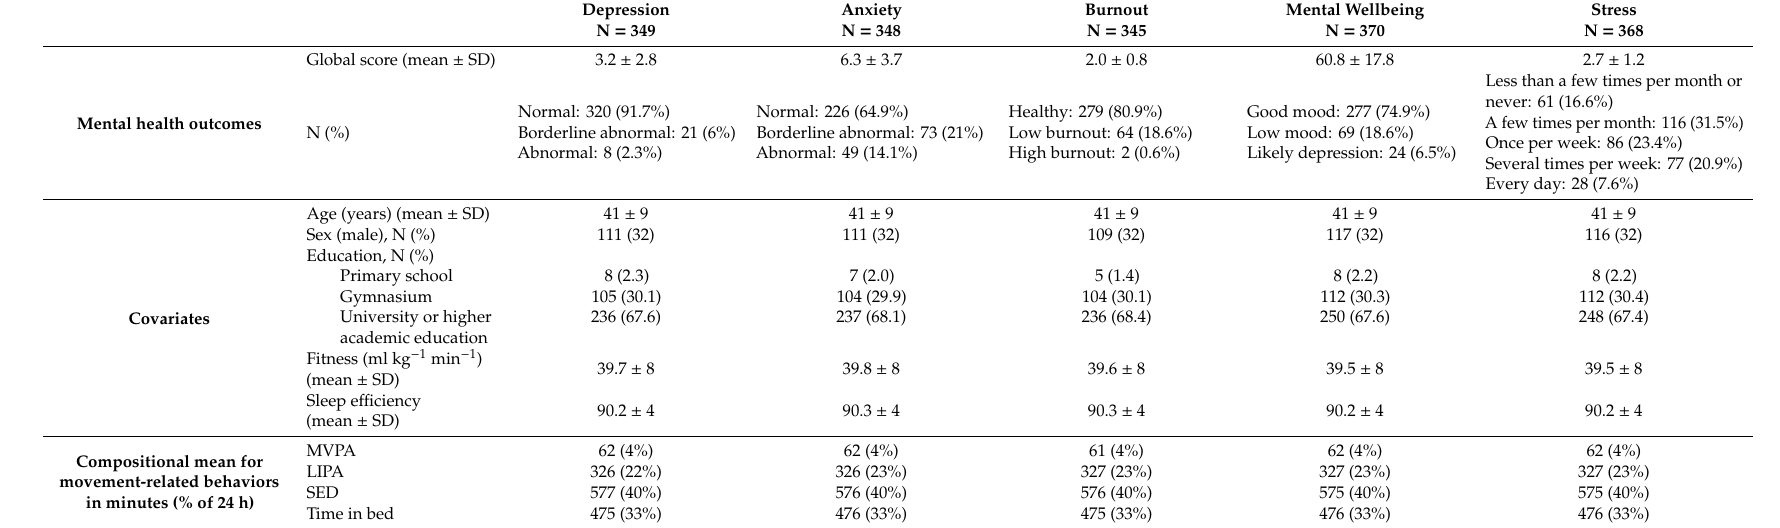
Table 1. Descriptive characteristics for each analytic sub-sample, containing only complete